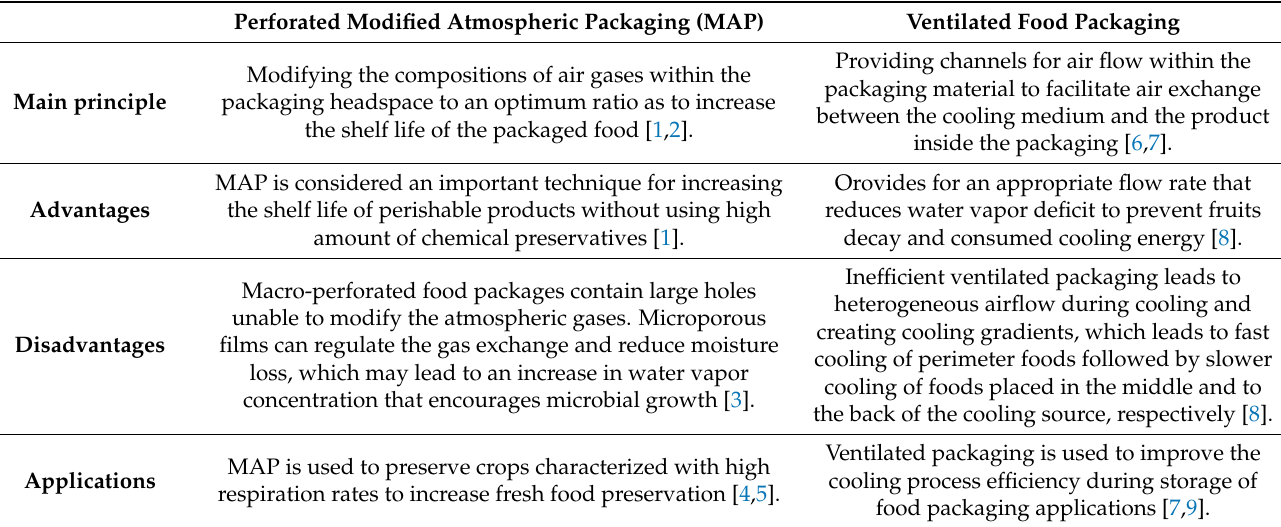
Table 1. Summary of the main characteristics of perforated modified atmospheric packaging (MAP) and ventilated food packaging. Perforated Modified Atmospheric Packaging (MAP) Ventilated Food Packaging